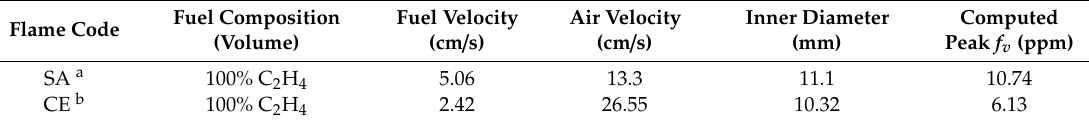
Table 2. The characteristics of two flames used as unseen data for the rigorous test (experimental work of a Santoro et al. [65]; experimental and numerical studies of b Cepeda et al. [66]).